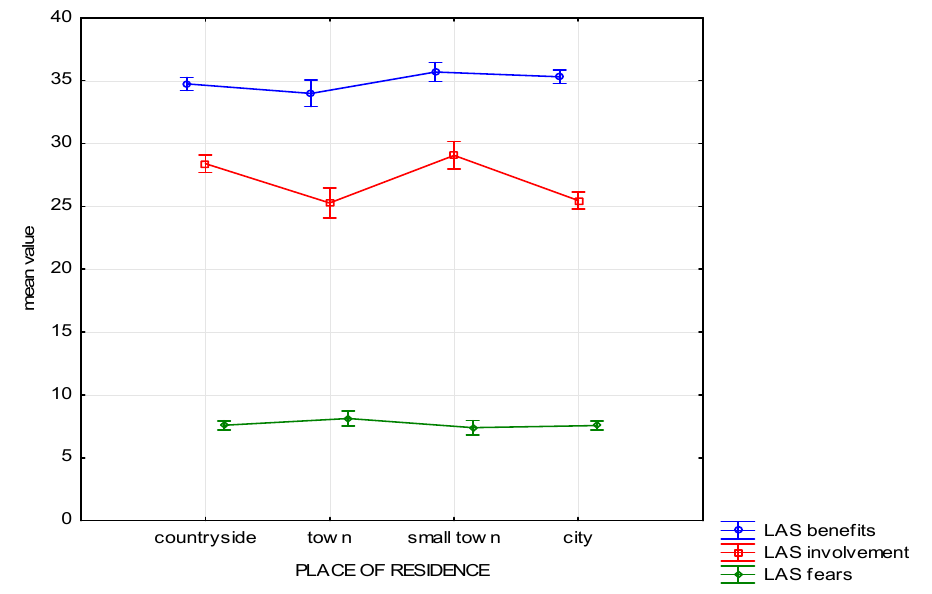
Figure 3. Attitude to the forest—mean chart for groups based on the place of residence.